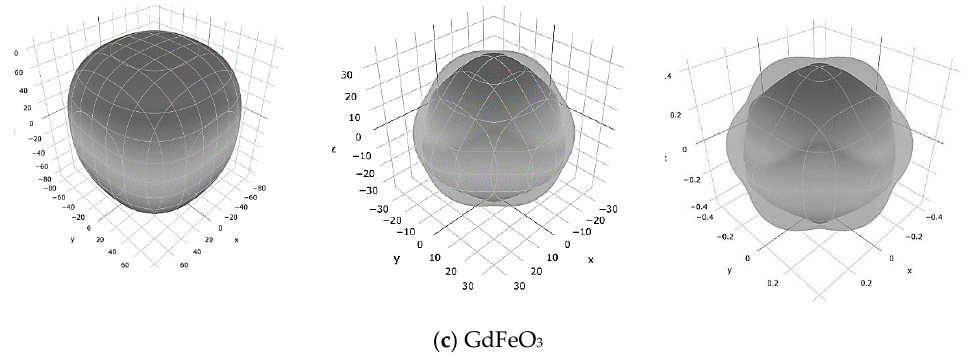
Figure 3. 3D contours of Young’s modulus, shear modulus, and Poisson’s ratio for ( a ) LaFeO 3 ; ( b ) EuFeO 3 , and ( c ) GdFeO 3 . Table 5. Properties of electron density critical points of RFeO 3 (R = La, Eu, Gd).